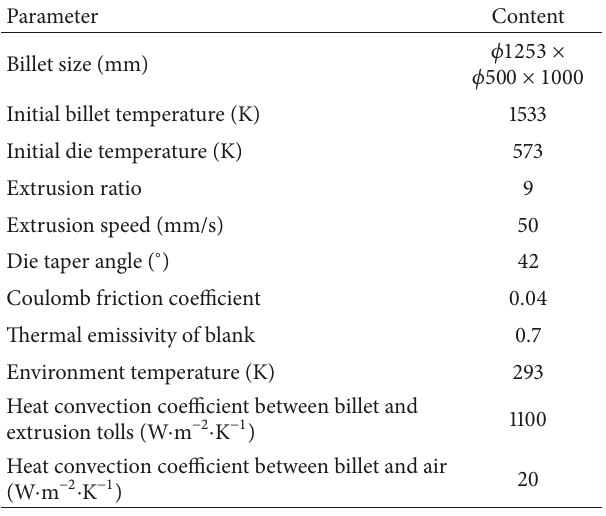
Table 3: Hot extrusion parameters setting for the thermal- mechanical coupled FE model.